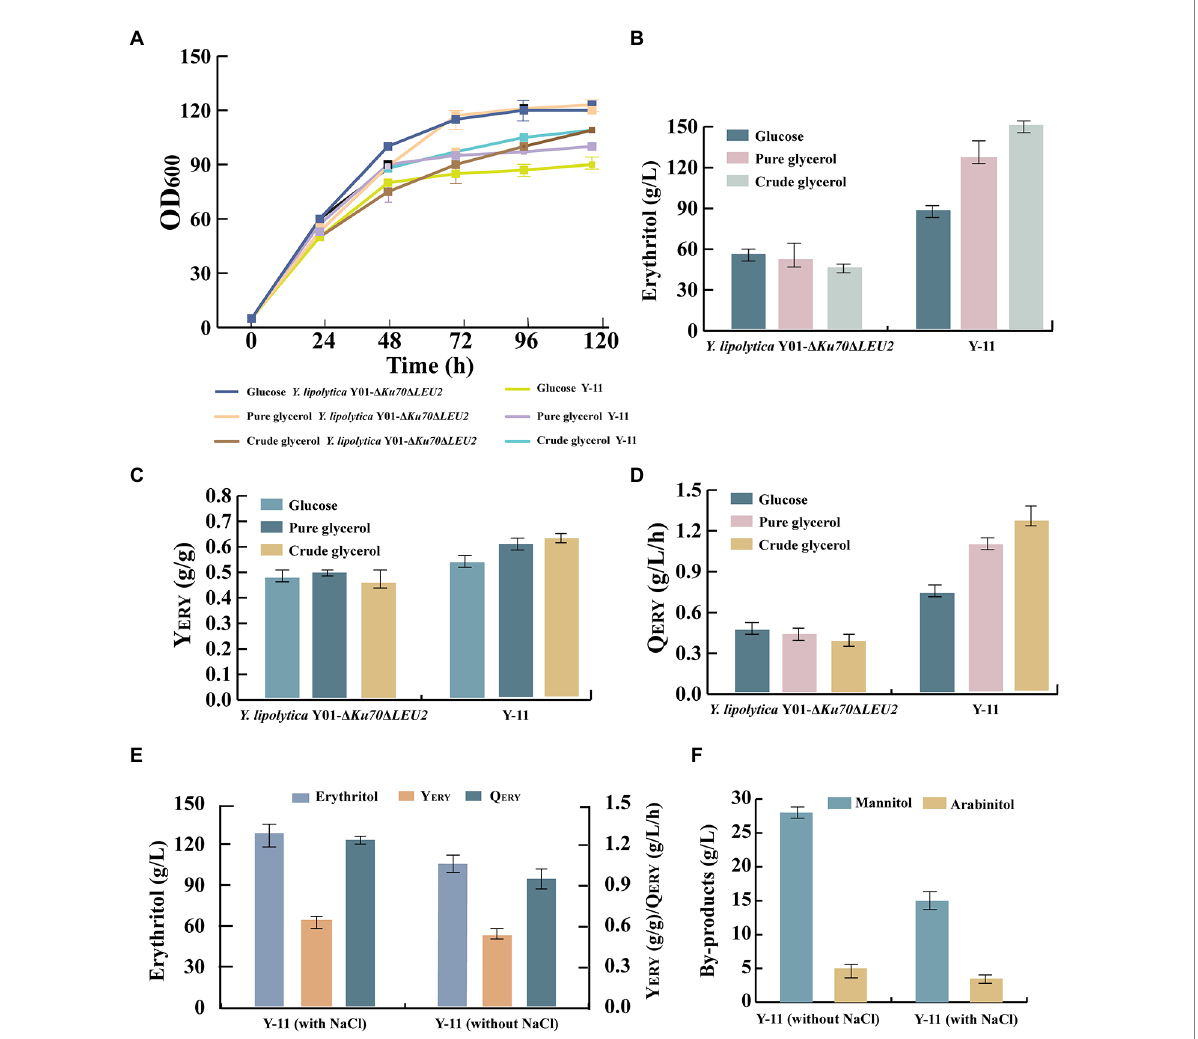
FIGURE 6 The parameters of the processes conducted in batch bioreactor cultivation. (A) OD 600 of strains Y. lipolytica Y01- Δ Ku70 Δ LEU2 and Y-11 in different carbon sources. (B) Erythritol titers of strains Y. lipolytica Y01- Δ Ku70 Δ LEU2 and Y-11 in different carbon sources. (C) Erythritol yield of strains Y. lipolytica Y01- Δ Ku70 Δ LEU2 and Y-11 in different carbon sources. (D) Erythritol productivity of strains Y. lipolytica Y01- Δ Ku70 Δ LEU2 and Y-11 in different carbon sources. (E) Erythritol titers, yield and productivity of Y-11with NaCl or without NaCl. (F) The main by-products of Y-11 with NaCl or without NaCl. Three biological replicates were used to obtain the data. The error bars represented the standard